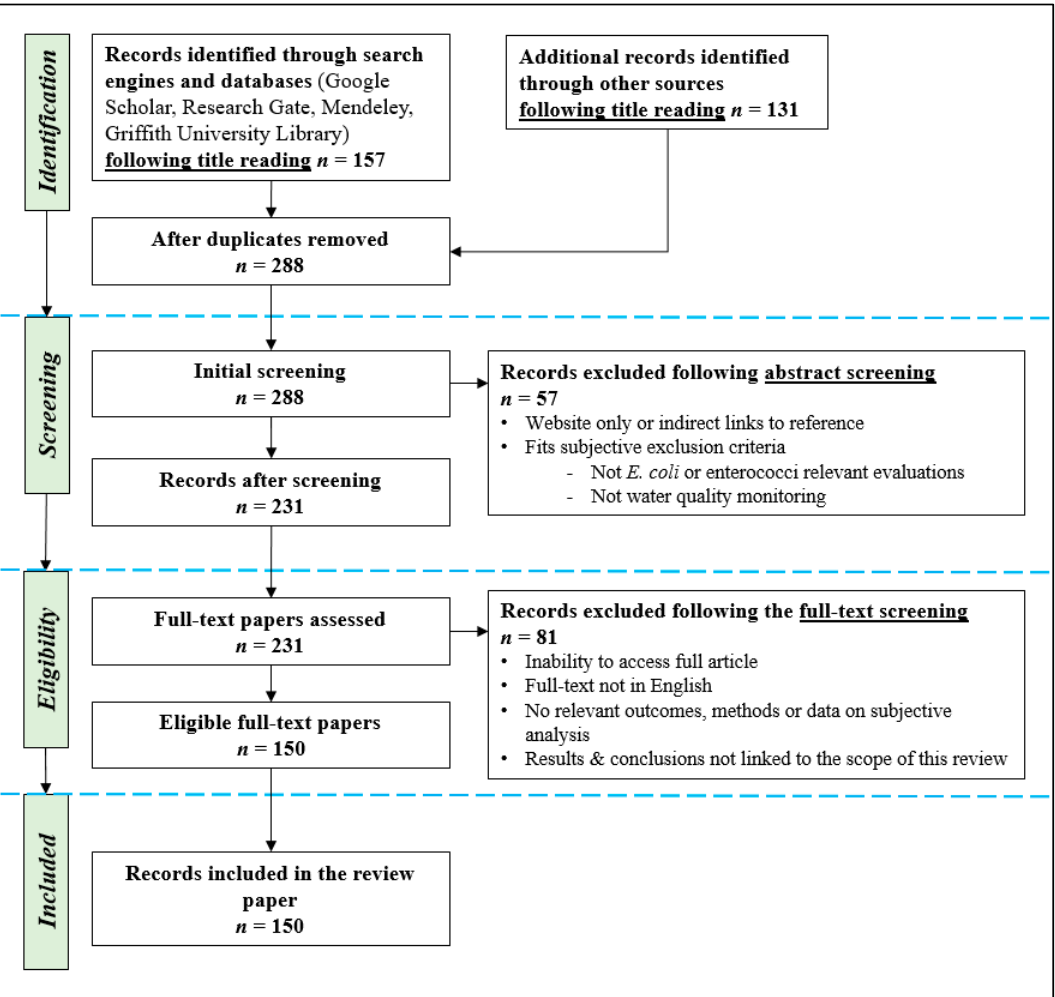
Figure 1. Literature review methodology, with screening through a three-stage filtering process: (1)